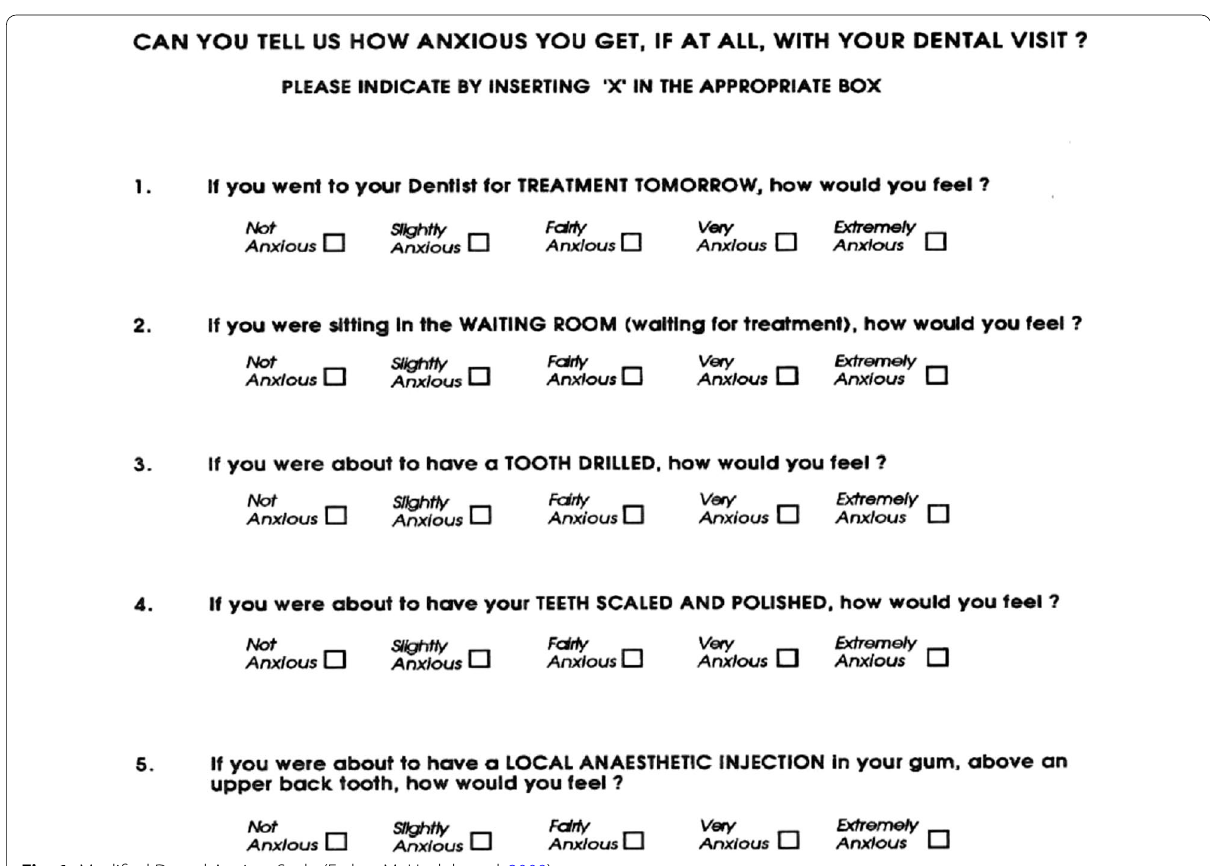
Fig. 1 Modified Dental Anxiety Scale (Farhat-McHayleh et al.